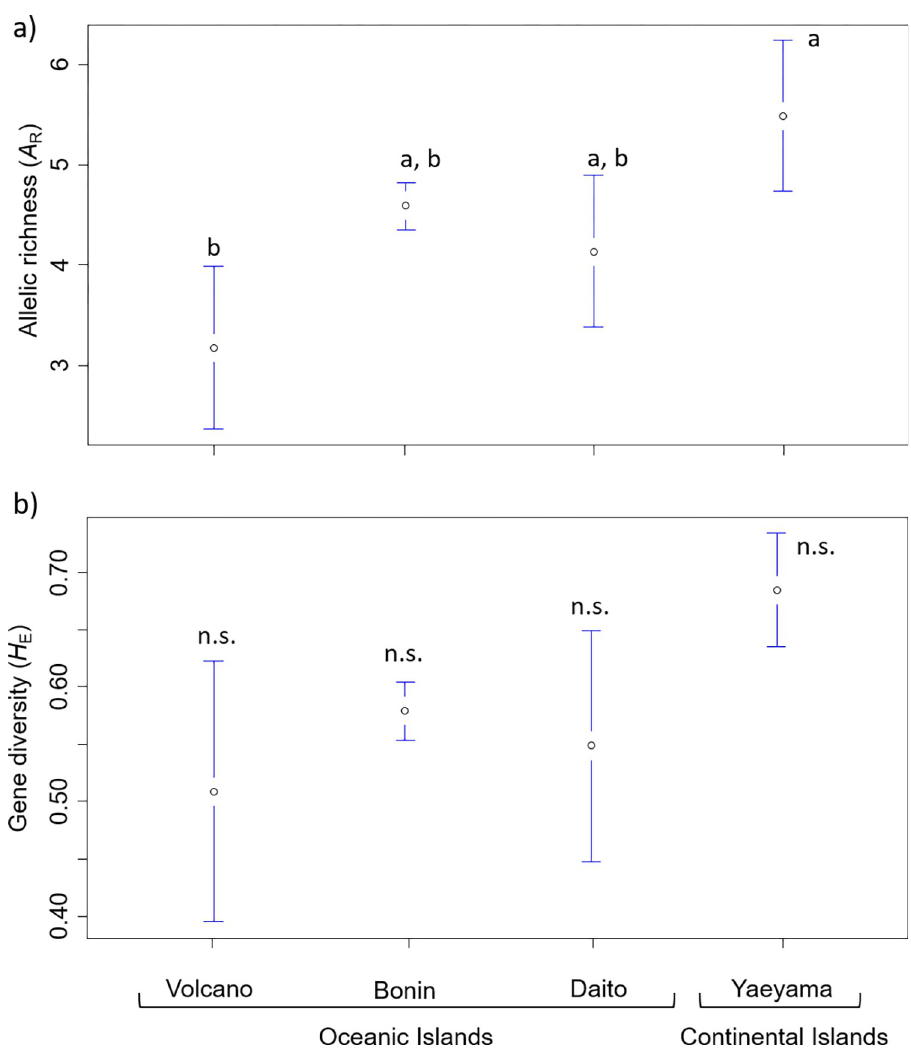
Fig 5. Mean allelic richness ( A R ) and gene diversity ( H E ) in the four islands of Planchonella ovobata ( ± SE). Different letters indicate significant differences among islands ( p < 0.05, pairwise t-test with Bonferroni correction). Island groups are ordered from youngest (left) to oldest